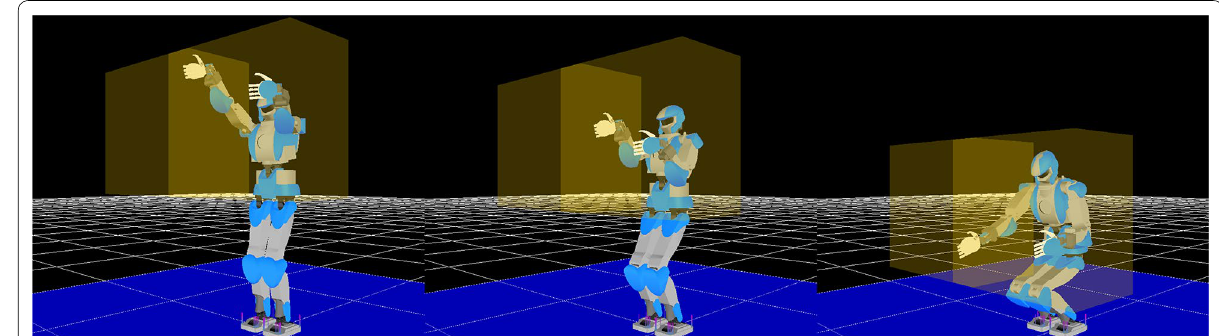
Fig. 4 Reachable areas (yellow boxes) of the proposed method in the three configurations of the CoM (Eq.